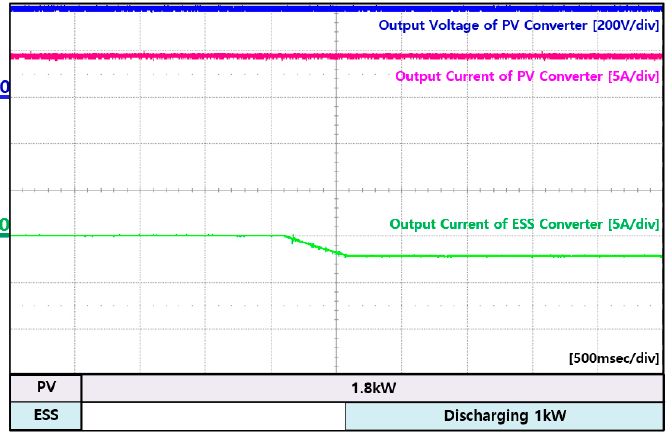
Figure 24. Experiment waveforms of DC load and multi-level inverter in mode 4.